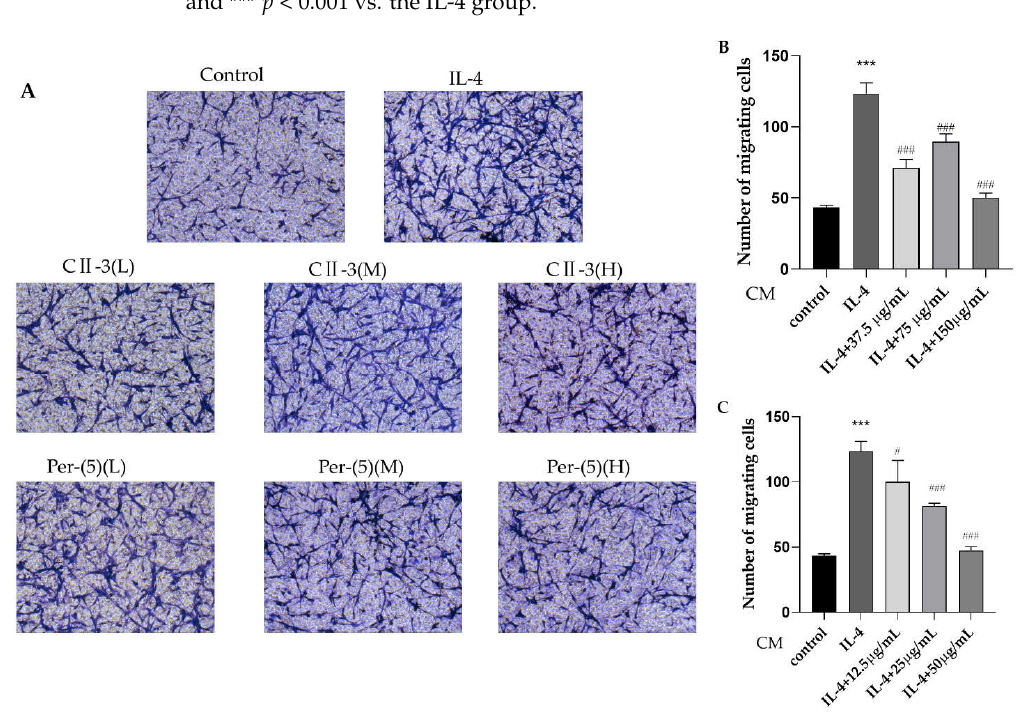
Figure 7. Impacts of CM on migration of CT26.WT cells. Transwell assays of CT26.WT cells following treatment with CM ( A ); number of migrating cells of CT26.WT treated with CM of CII-3 ( B ) and pericanaside ( 5 ) ( C ). *** p < 0.001 vs. the control group; # p < 0.05, ## p < 0.01, and ### p < 0.001 vs. the IL-4 group.